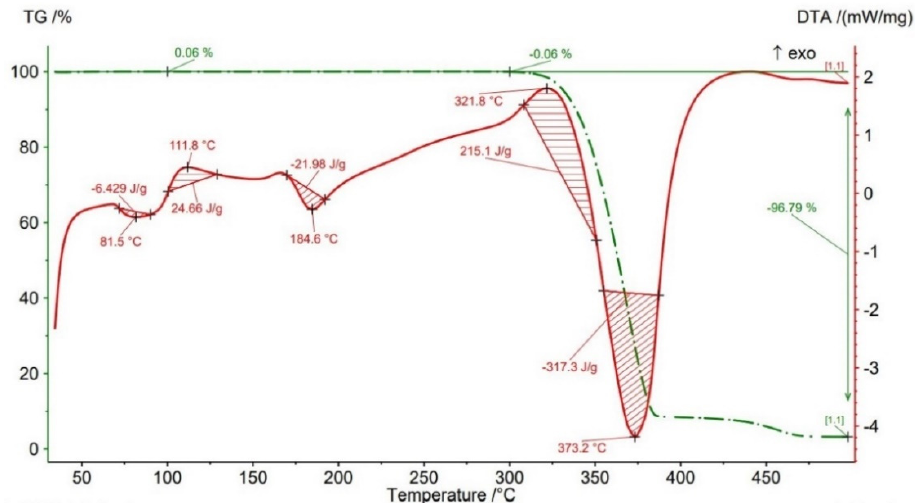
Figure 13. TGA results for sample with 25% infill density.